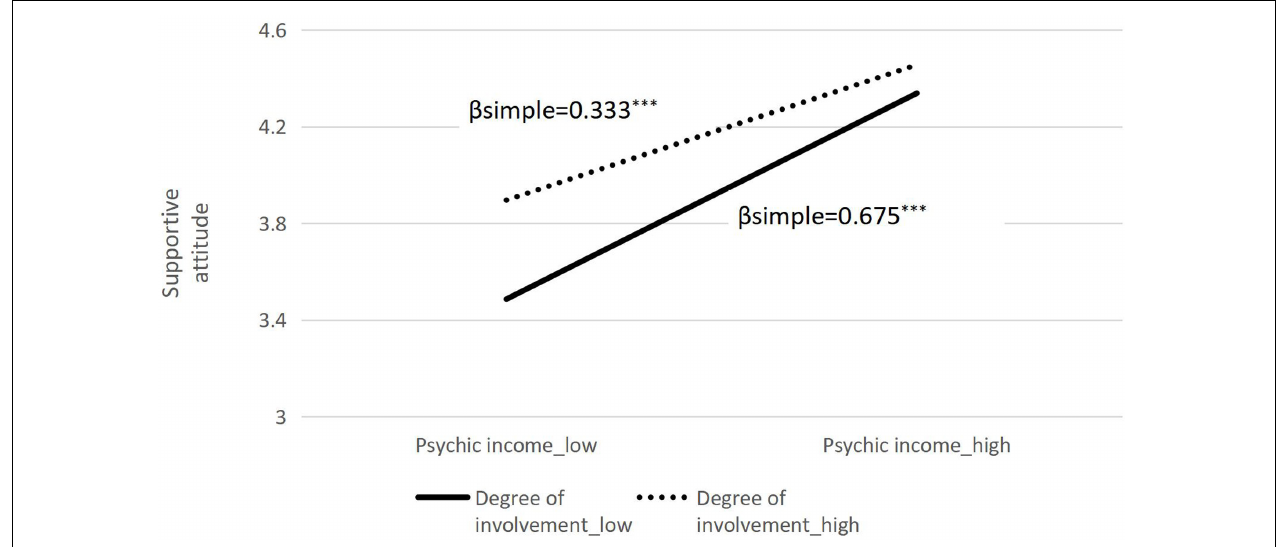
FIGURE 2 | Moderating effect of involvement between psychic income and attitude. ***Refers to P < 0.001 (the same as